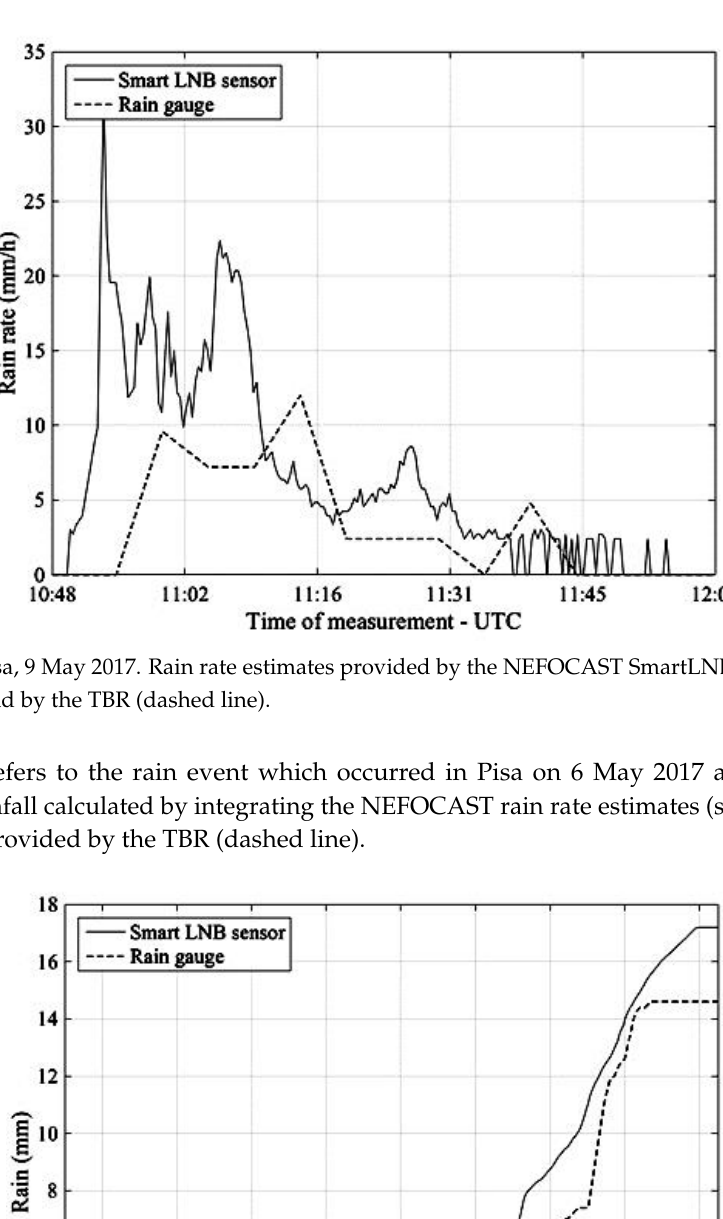
Figure 11. Pisa, 6 May 2017. Rain rate estimates provided by the NEFOCAST SmartLNB-based sensor (solid line) and by the TBR (dashed line).